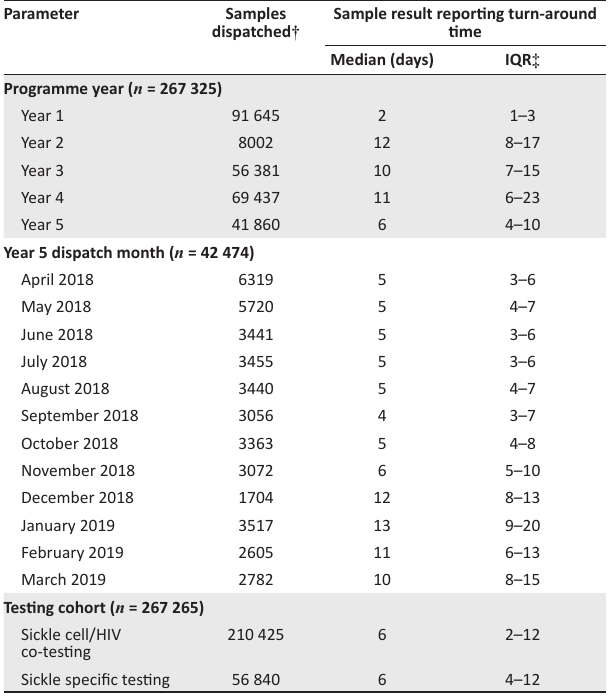
TABLE 4: Sample result reporting phase turn-around time for sickle cell samples collected in Uganda, by parameter, February 2014 to March 2019. Parameter Samples dispatched †